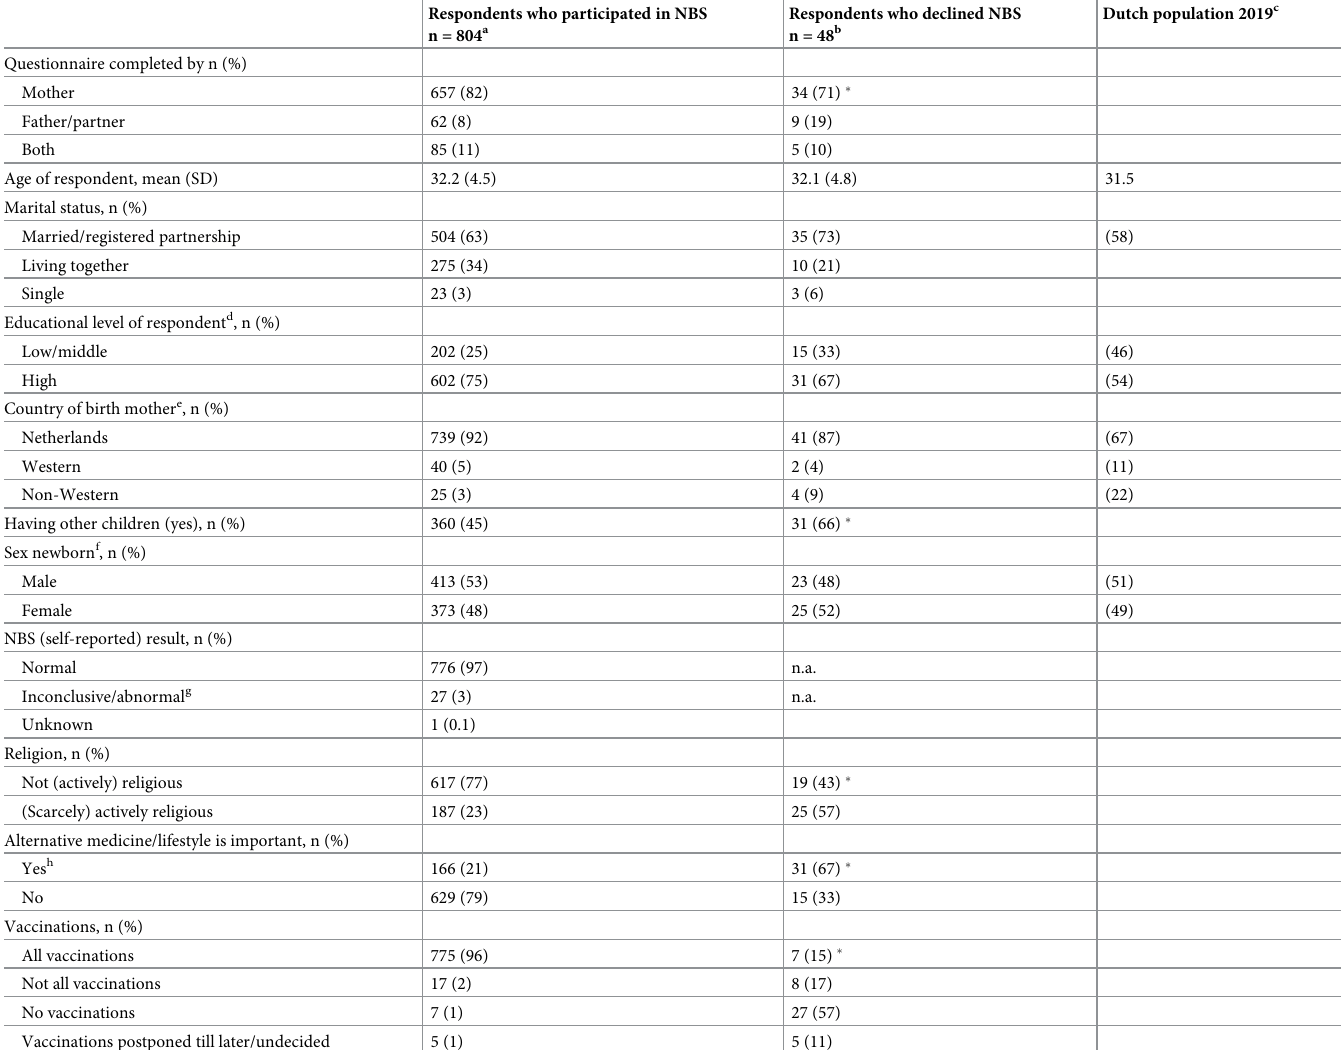
Table 1. Characteristics of respondents who participated in NBS participants or declined NBS, compared to the general Dutch